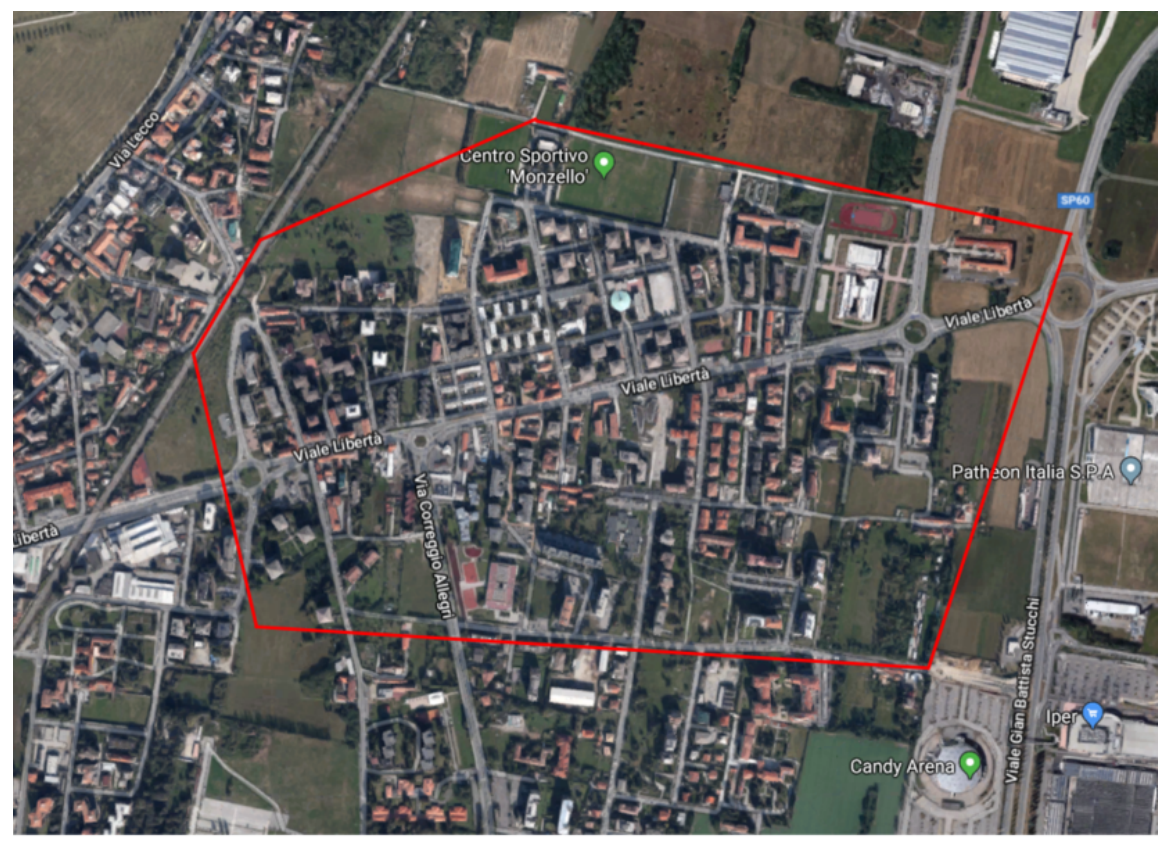
Figure 1: NLEZ pilot area boundaries (Libertà